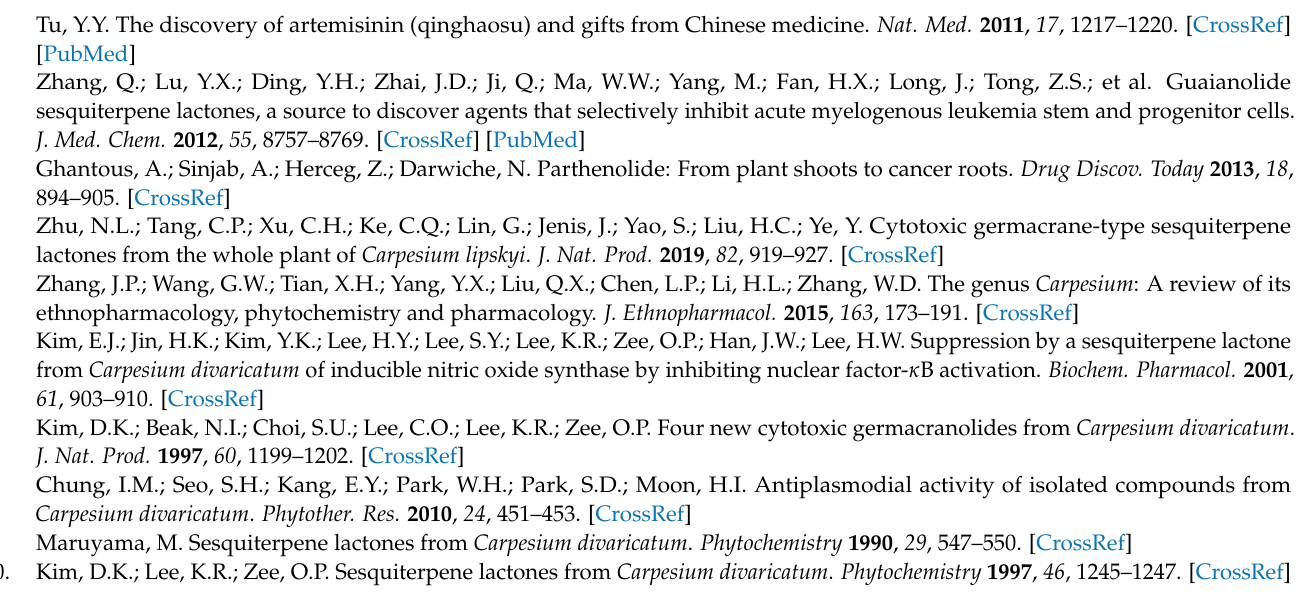
6 ; Figure S7.1–S7.10: 1 H, 13 C NMR, HSQC, HMBC, COSY, NOESY, UV, IR HRESIMS, and spectra of compound 7 ; Figure S8.1–S8.10: 1 H, 13 C NMR, HSQC, HMBC, COSY, NOESY, UV, IR HRESIMS, and spectra of compound 8 ; Table S1–S7: X-ray data of compound 1 . Table S8–S9: Conformational Analysis of 5Ja – 7Ja